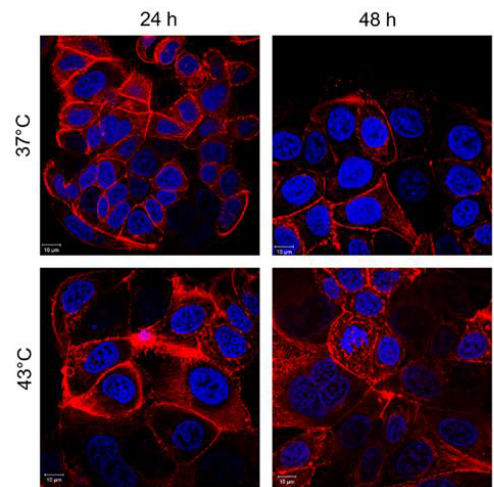
Figure 8. Effects of temperature on actin network of MCF-7 cells after 24 h and 48 h. Cells were fixed